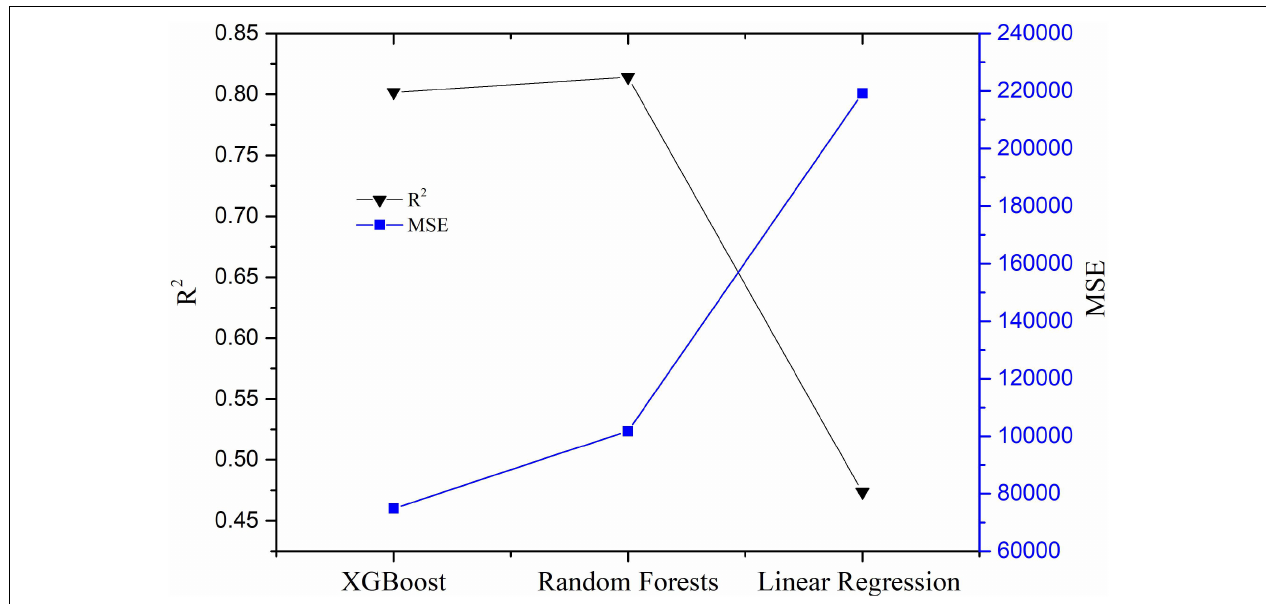
FIGURE 2 | The comparison of the goodness of fit ( R 2 ) and mean squared error (MSE) of the three algorithms: the black inverted triangle represents R 2 , and the blue square is the MSE.